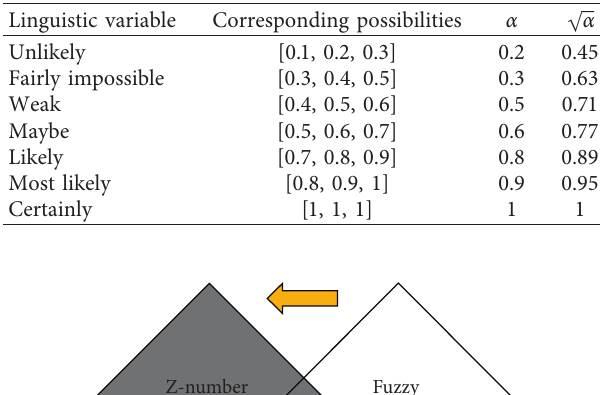
Table 3: Z-number corresponding possibilities. Linguistic variable Corresponding possibilities